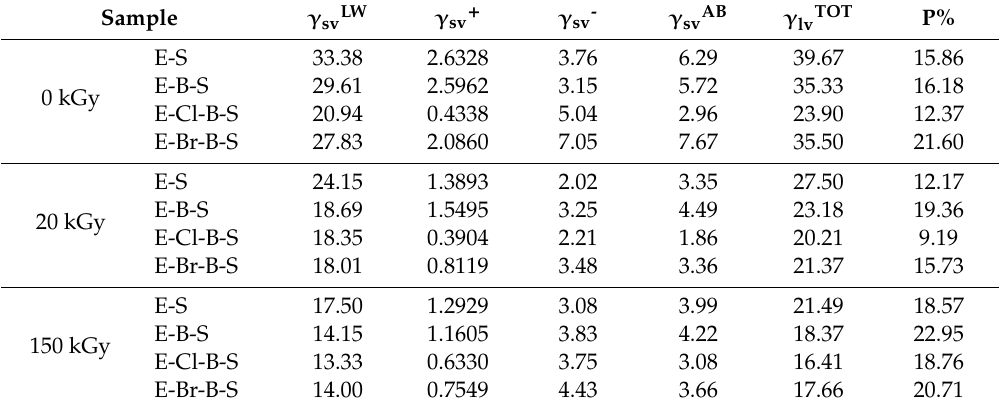
Table 6. Surface free energy and polar and dispersive components values of samples before and after electron beam irradiation; all values are expressed in mN / m, excepting P.